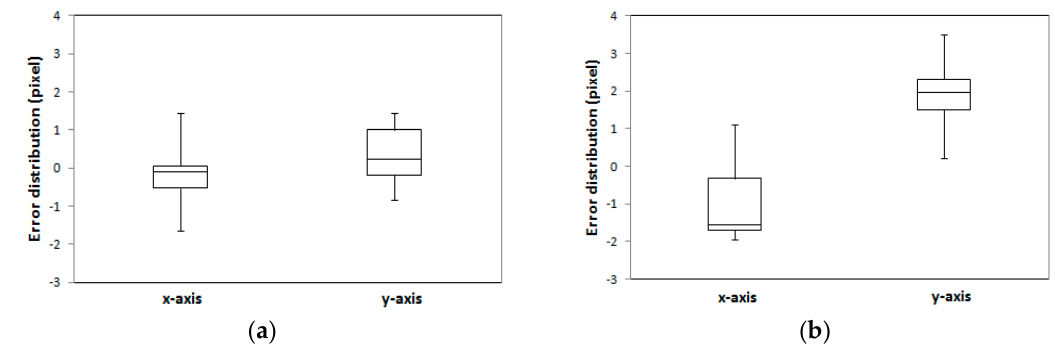
Figure 13. Error distributions for 16 check points when ( a ) manually digitized building models are used and ( b ) LiDAR-driven building models are used.